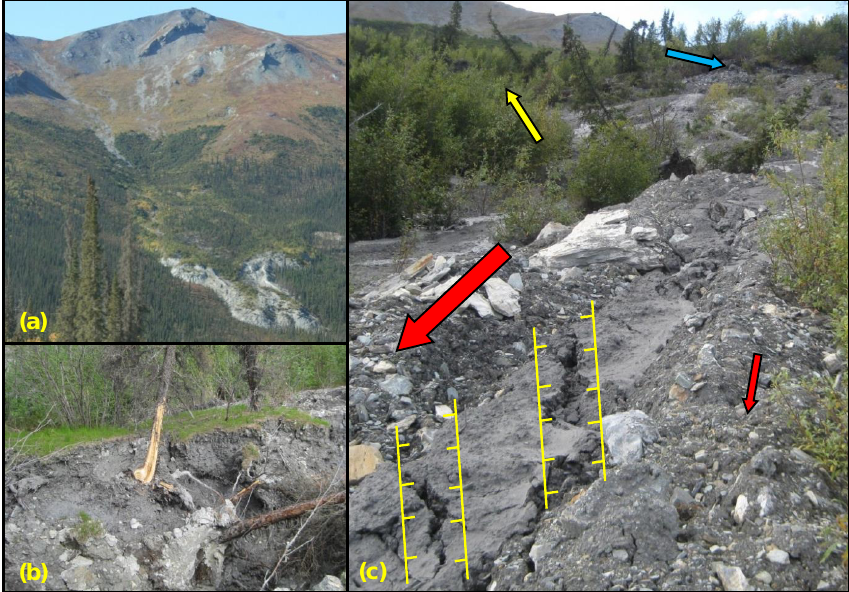
Figure 10. Features of FDL-7. (a) Deflation of the main lobe body towards the lower tongue, and the major RTSs along the right and left flanks. (b) Vegetation on the lower tongue, including a completely split spruce tree demonstrating about 20cm of previous sedimentation along its trunk. (c) Along the left flank of the lower tongue of FDL-7, differing rates of movement are indicated by the larger red arrow on the lobe and the smaller red arrow on the levee (far right). Echelon cracks are annotated to show extension. The RTS that was the source of the debris flow is indicated by the blue arrow, and an area of leaning trees is indicated by the yellow